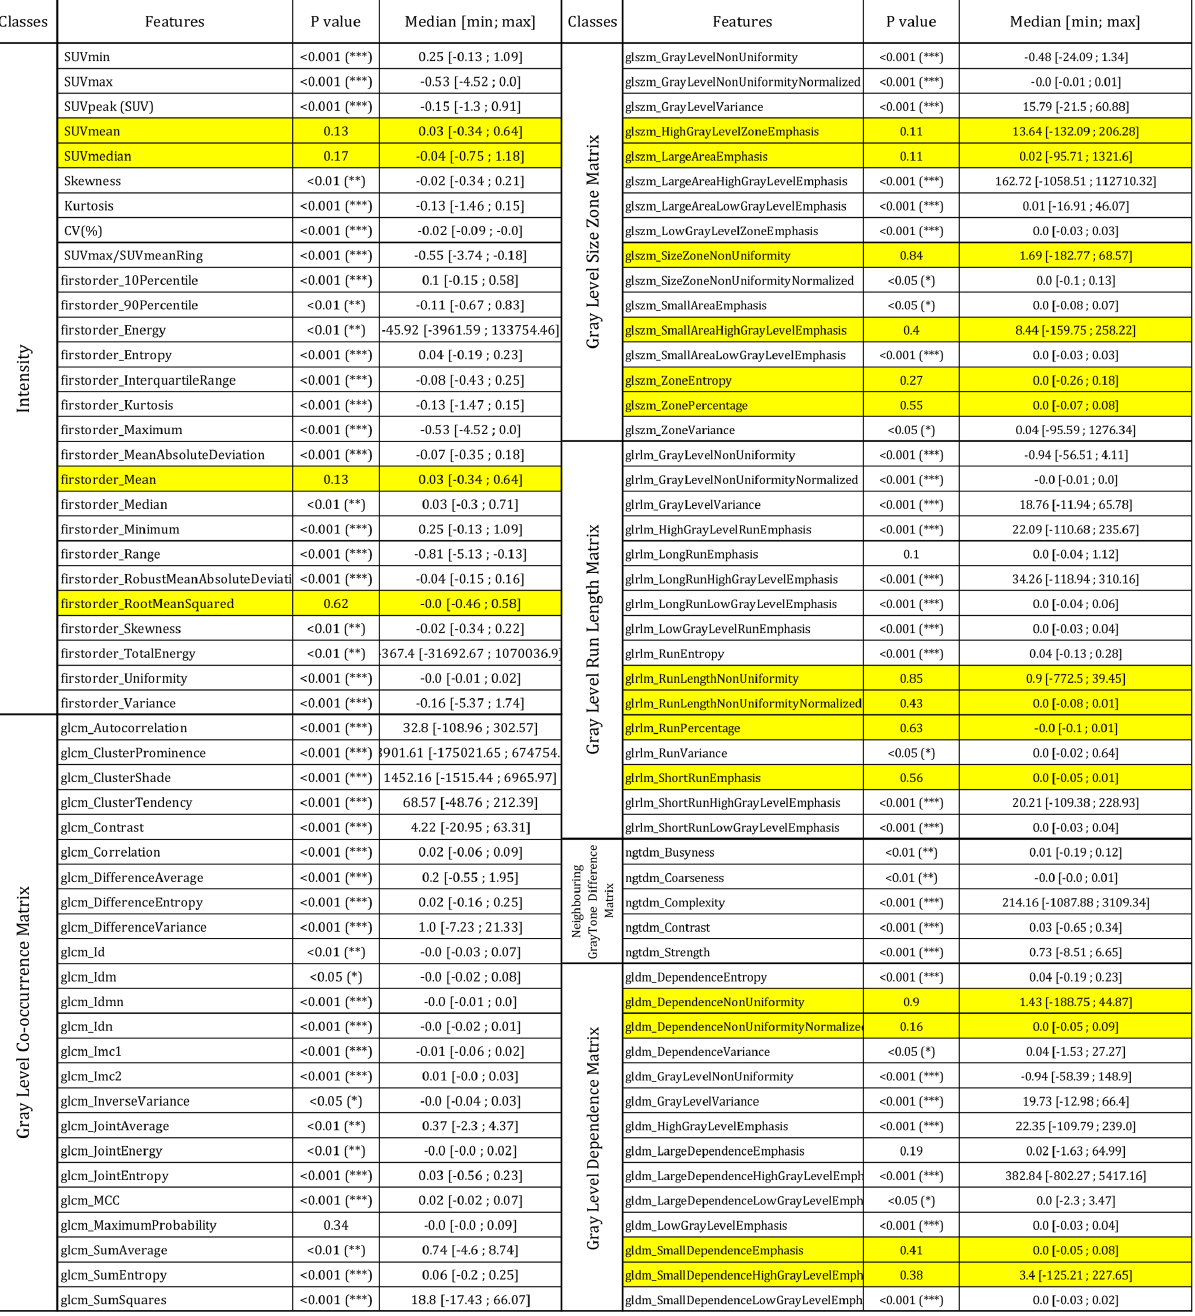
TABLE 2 | Result of Wilcoxon signed rank test of all the features between AI denoised and original images in